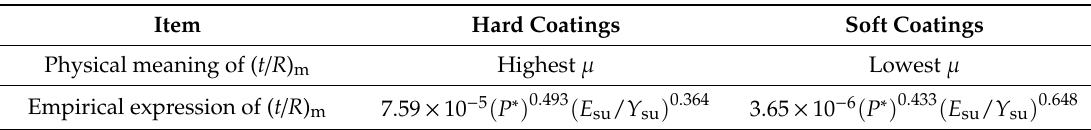
Table 3. A summary of physical meaning and empirical expressions of ( t / R ) m for hard [43] and soft coatings [45].